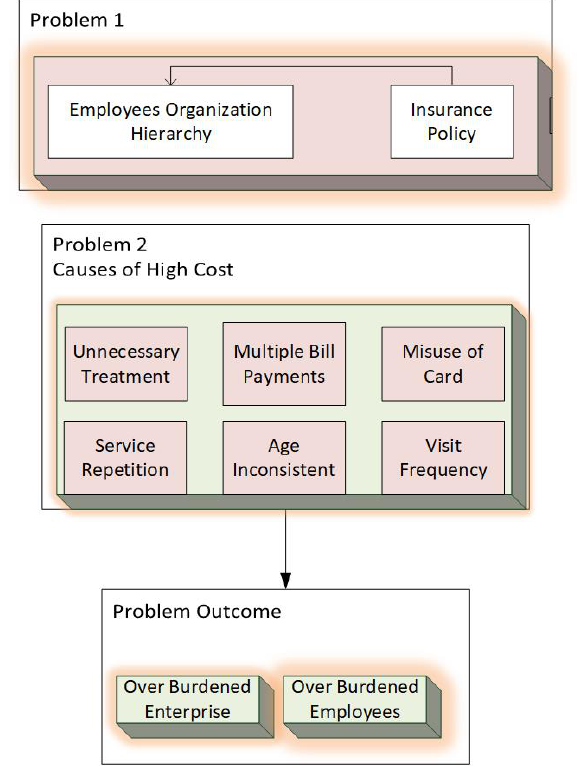
Figure 1. Description of problems to be